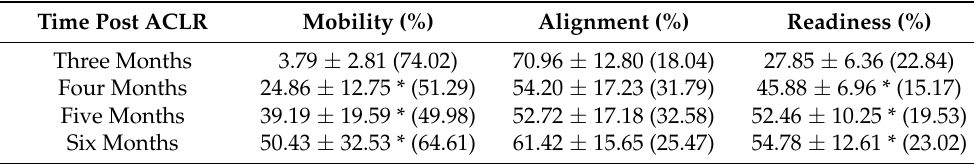
− Table 2. Descriptive statistics ( x ± SD) and coefficient of variation percentage (CV%) for each biometric variable obtained from an innovative three-dimensional markerless motion capture system. Time Post ACLR